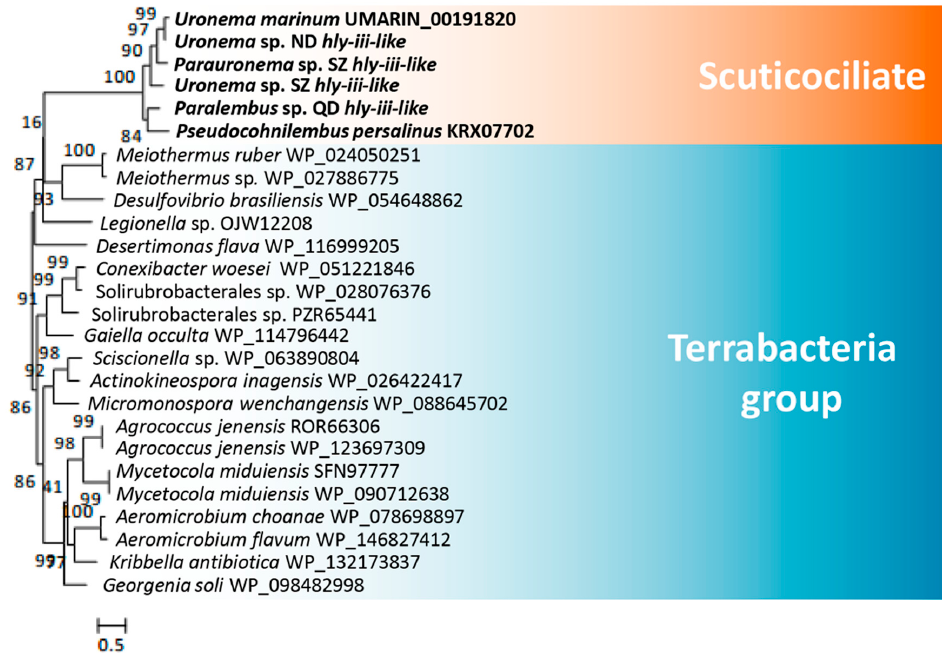
Figure 5. Phylogenetic tree of hly-iii-like genes in scuticociliates and bacteria . hly-iii-like genes were identified in all scuticociliates. The top 20 prokaryotic BLASTP hits (using the encoded U. marinum Hly-III-like proteins as the seed sequence) in the NCBI non-redundant protein database were used to construct the phylogenetic tree.